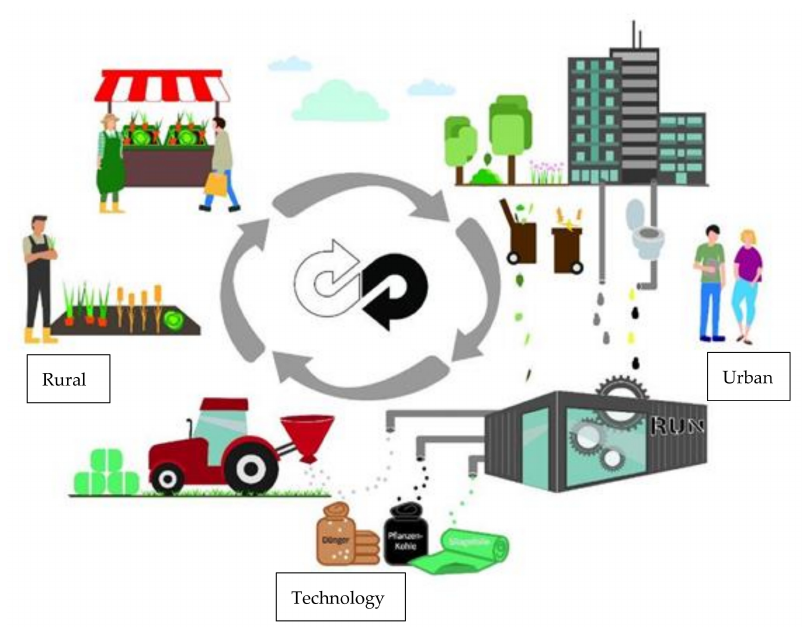
Figure 1. High-tech concept (1) of a rural urban nutrient partnership (RUN), as an example for short circular economy [18]. The image shows the closure between urban ( right side ) and rural areas ( left side ). The RUN plant produces fertilizer, plant charcoal, and biopolymers.